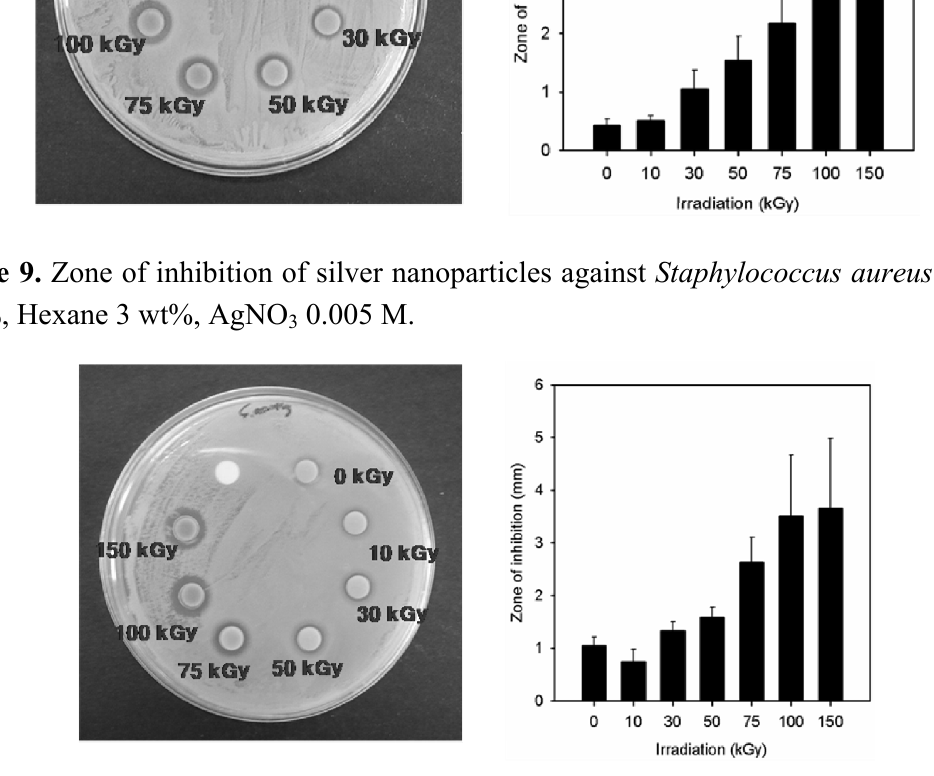
Table 1. Antibacterial effect data of Ag/PAAc nanogel against Escherichia coli